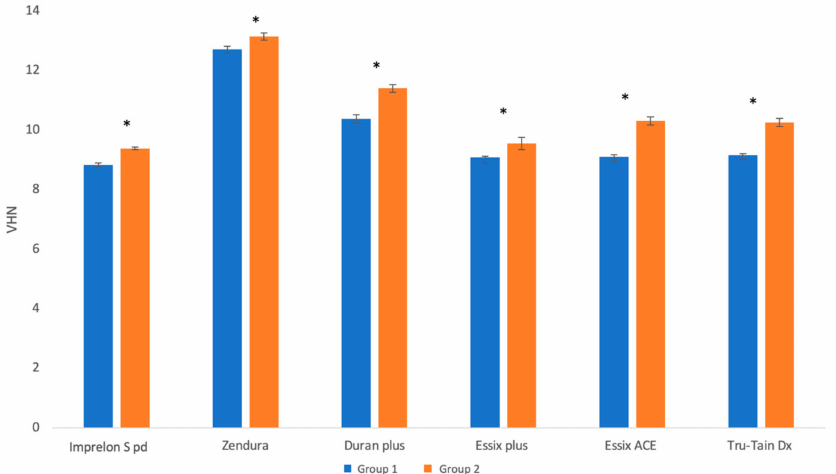
Figure 8. Mean ± SD of hardness values of Group 1 and Group 2 (the * symbol indicates a significant difference between the two groups for the same material at p < 0.05 level).